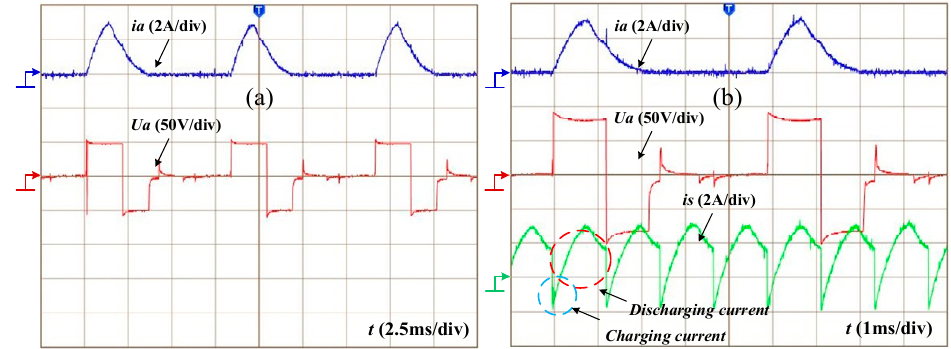
Figure 19. Experimental waveforms of full-speed performance with SRM driven by ( a ) the conventional converter and ( b ) the dual-source.